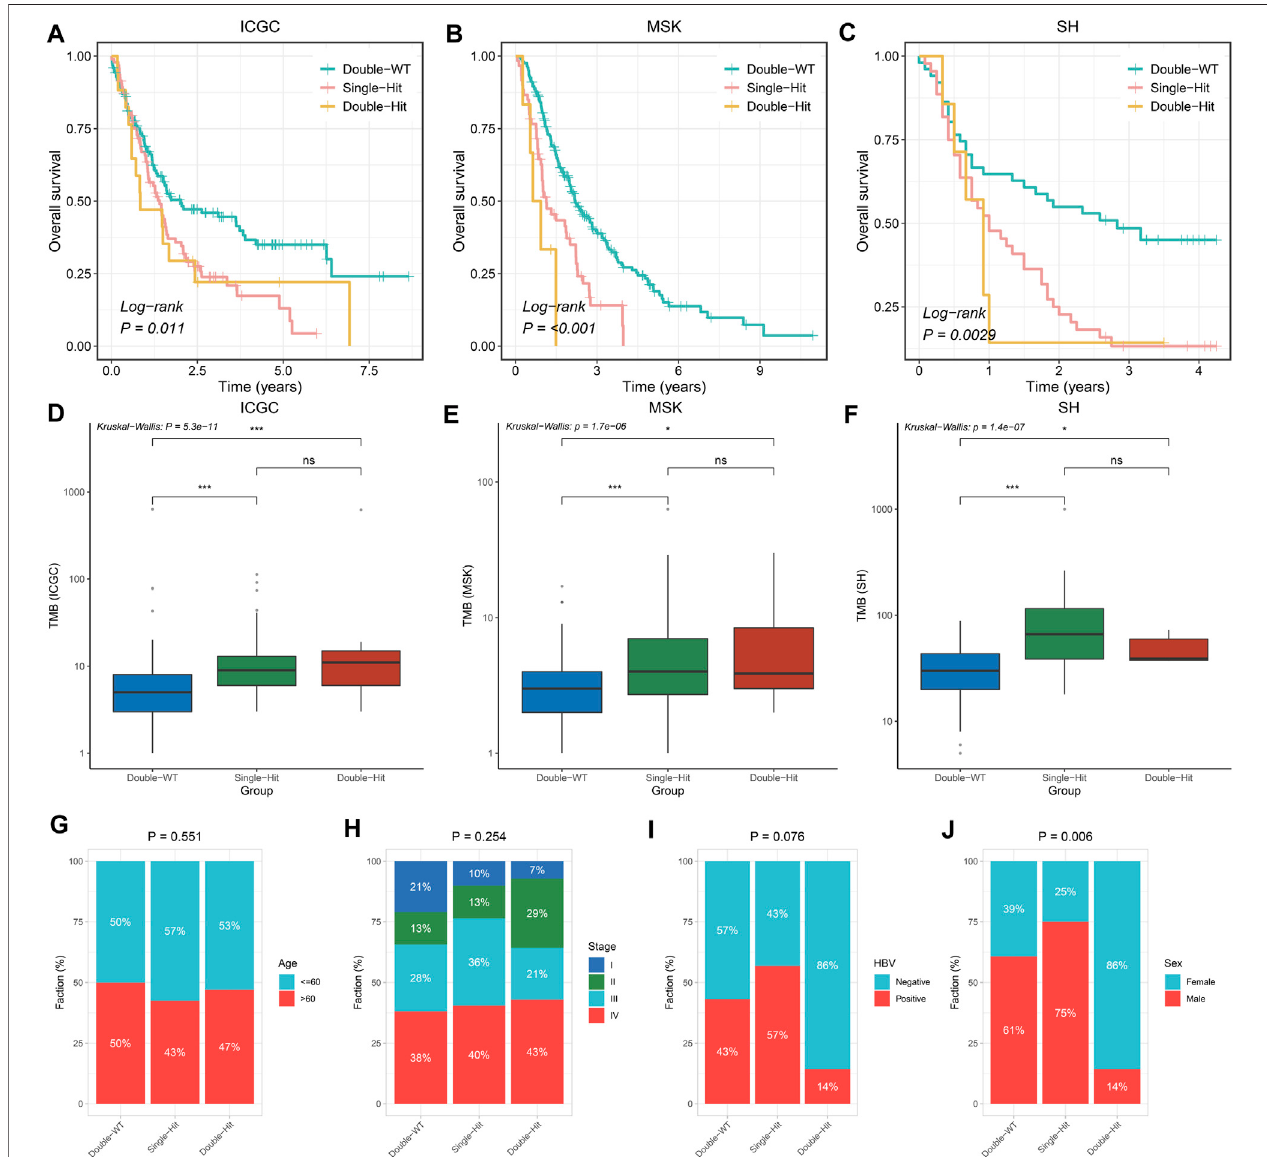
FIGURE 3 | Difference of clinical characteristics and prognosis among three TP53/KRAS mutant phenotypes in the three cohorts. (A – C) Kaplan – Meier survival analysisofthethreephenotypes. (D – F) BoxplotofTMBforpatientswiththreephenotypes. (G – J) CompositionpercentageofAge (G) ,AJCCstage (H) ,HBV (I) ,andSex (J) among the three phenotypes. ns p > 0.05; * p < 0.05; ** p < 0.01; *** p <